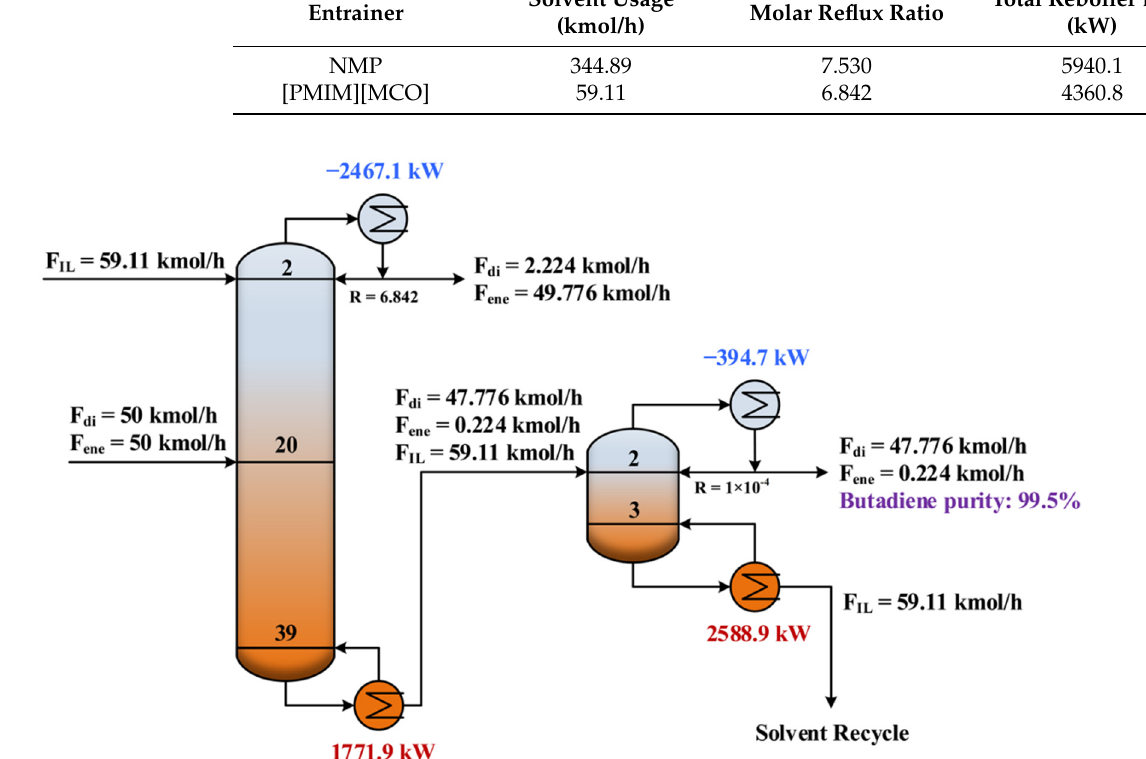
Figure 7. Optimal flowsheet of the ED process using [PMIM][MCO] as entrainer.